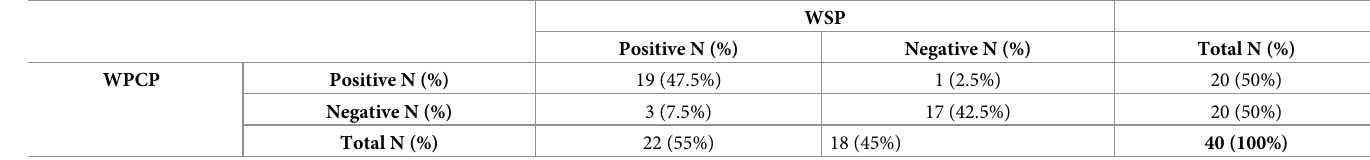
Table 2. Prevalence estimates of Wolbachia surface protein (WSP) and phage capsid protein (WPCP) DNA in Allonemobius socius crickets from Missouri.